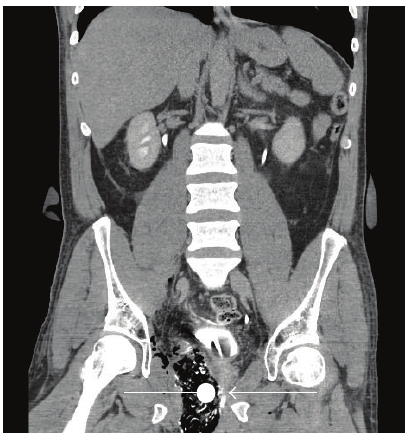
Figure 4: CT scan showing a big swab from the perineum into small pelvis to the right. Note that the swab (round mark) lies directly adjacent to the membranous urethra/transurethral catheter (arrow).